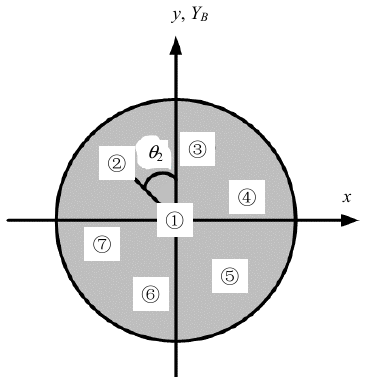
Fig. 8 Cross-section of optical